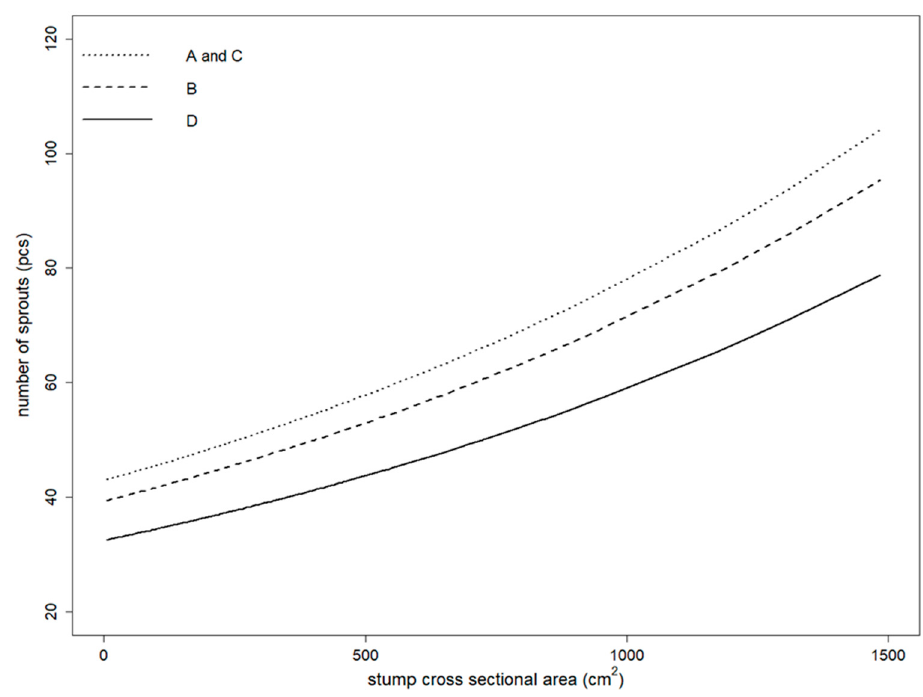
Figure 2. Fitted values of the number of sprouts per stump (species not taken into account) in relation to the stump cross sectional area and the management type (A: coppice-with-standards + raking + grazing; B: coppice-with-standards + grazing; C: coppice-with-standards + raking; and D: coppice- with-standards).